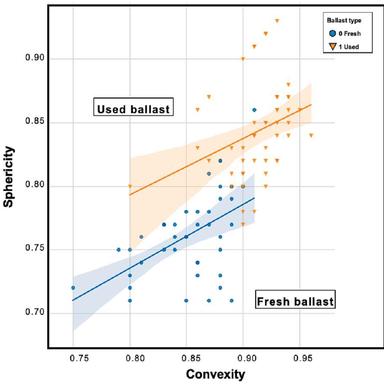
Linear plot of fresh and used ballast.